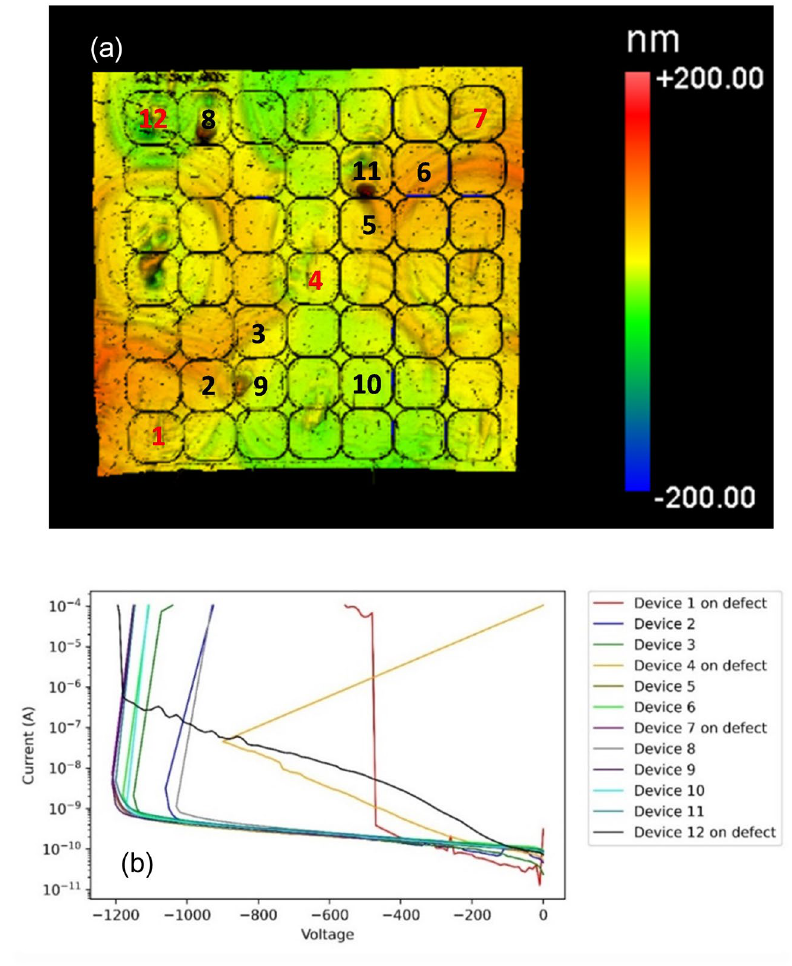
Figure 6. ( a ) Optical profilometry image of grid A is shown. Devices with red number are on point of high crystal stress. The devices tested with breakdown IV curves ( b ) are